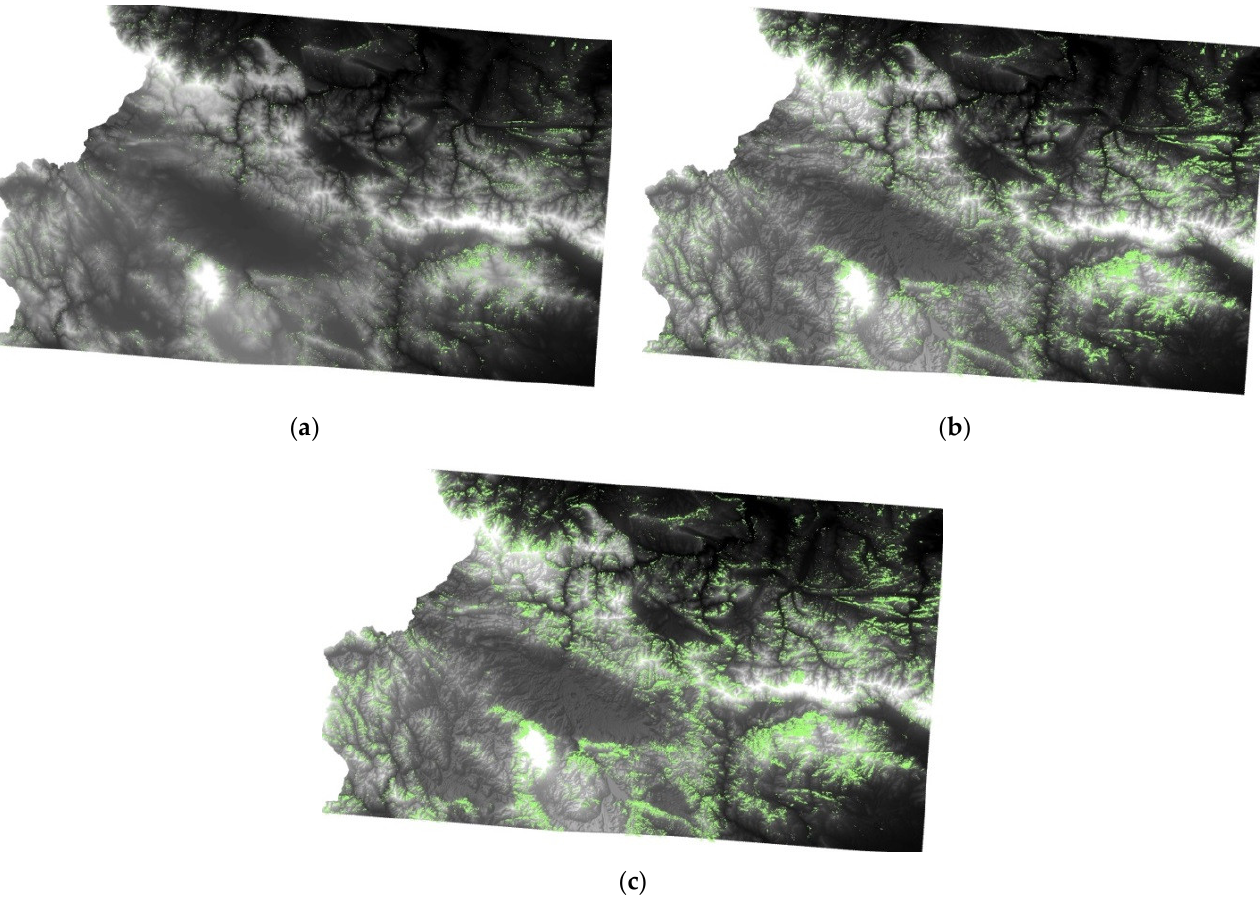
Figure 8. Distribution of broadleaved forests unaffected by drought (DC < 2) in the middle of August 2019 ( a ), at the beginning of September 2019 ( b ), and in the middle of September 2019 ( c ), scale 1:1,000,000.